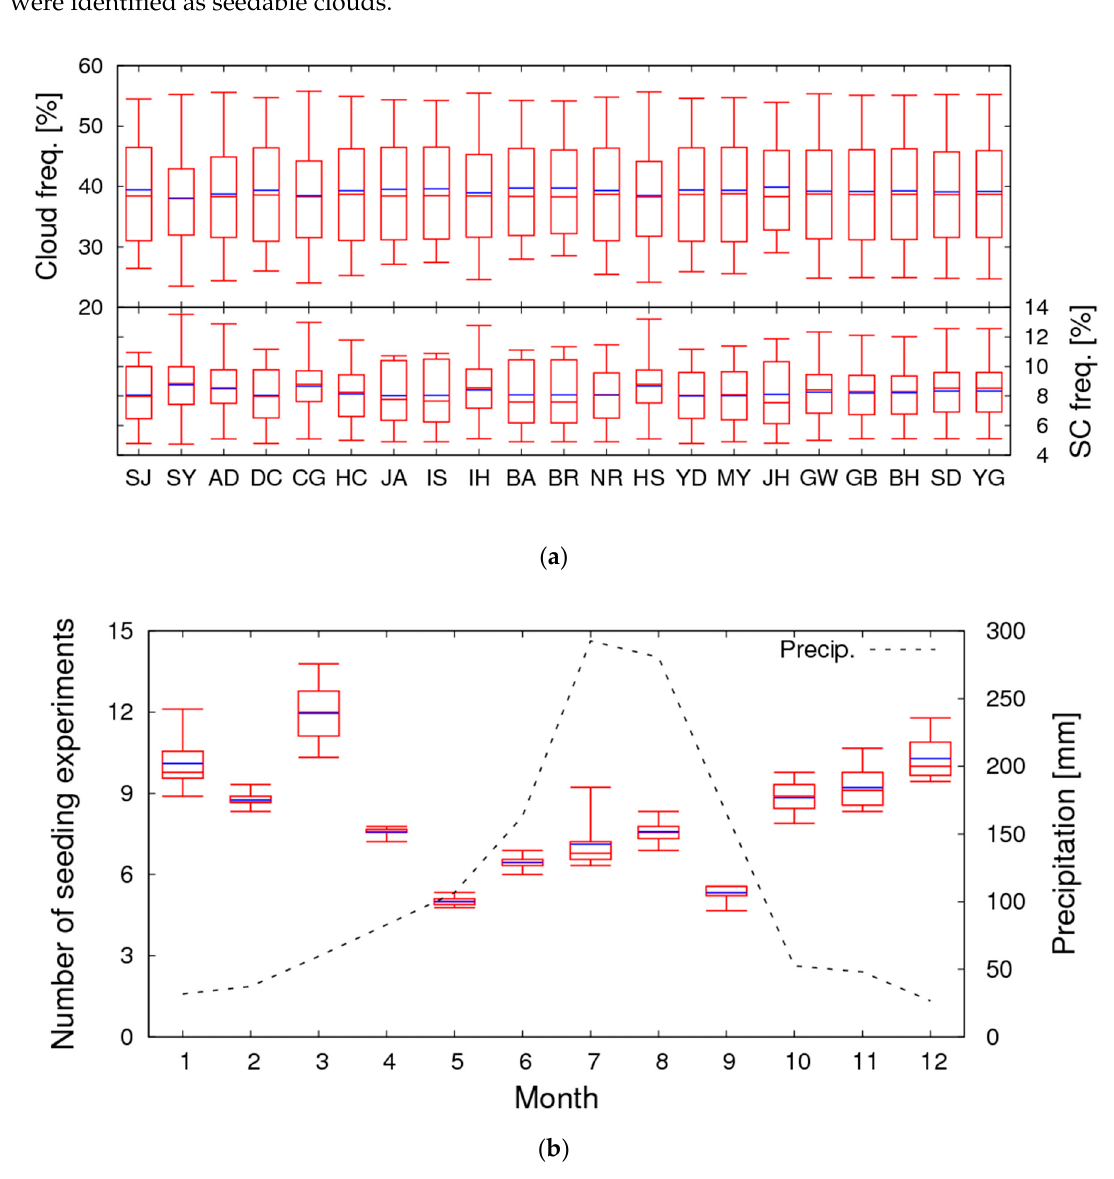
Figure 2. The quartile (0%, 25%, 50%, 75%, and 100%) and mean (blue line) of ( a ) frequency of occurrence of clouds and seedable clouds (SC) for each dam area and ( b ) the maximum monthly number of precipitation enhancement experiments, and distribution of mean monthly precipitation (dashed line) for normal year from